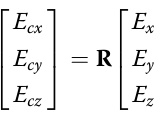
from the second-order nonlinear process of the funda- mental near-infrared lasing mode.